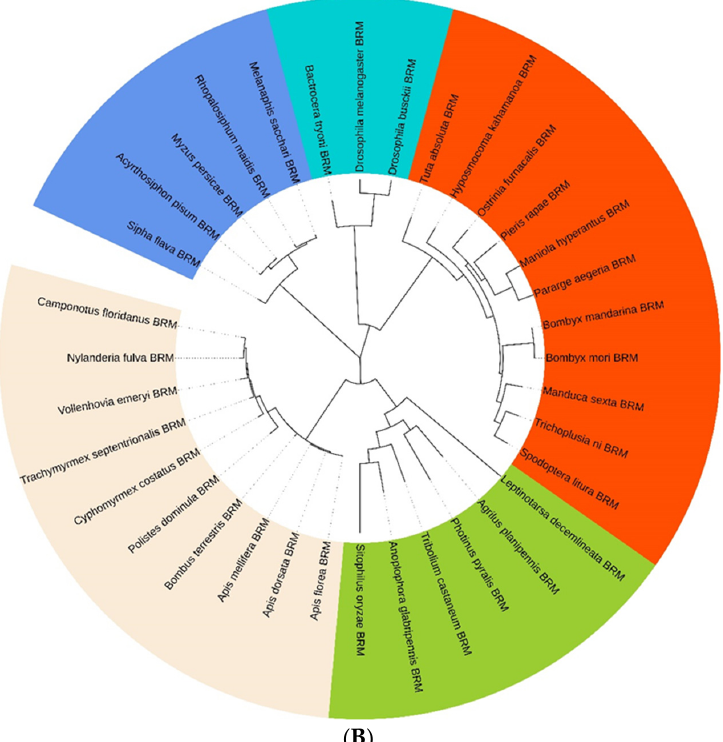
Figure 1. Phylogenetic tree based on known ISWI ( A ) and BRM ( B ) aa sequences. It was constructed in MEGA7.0 using ML method based on the Whelan Goldman (WAG) model with 1000 bootstrap replications. Lepidopterais depicted in vermilion; Hymenopterain in antique white; Coleopterain in yellow green; Diptera in sky blue; Hemipterain in cornflower blue. Table S1 lists ISWI and BRM protein sequence accession numbers.